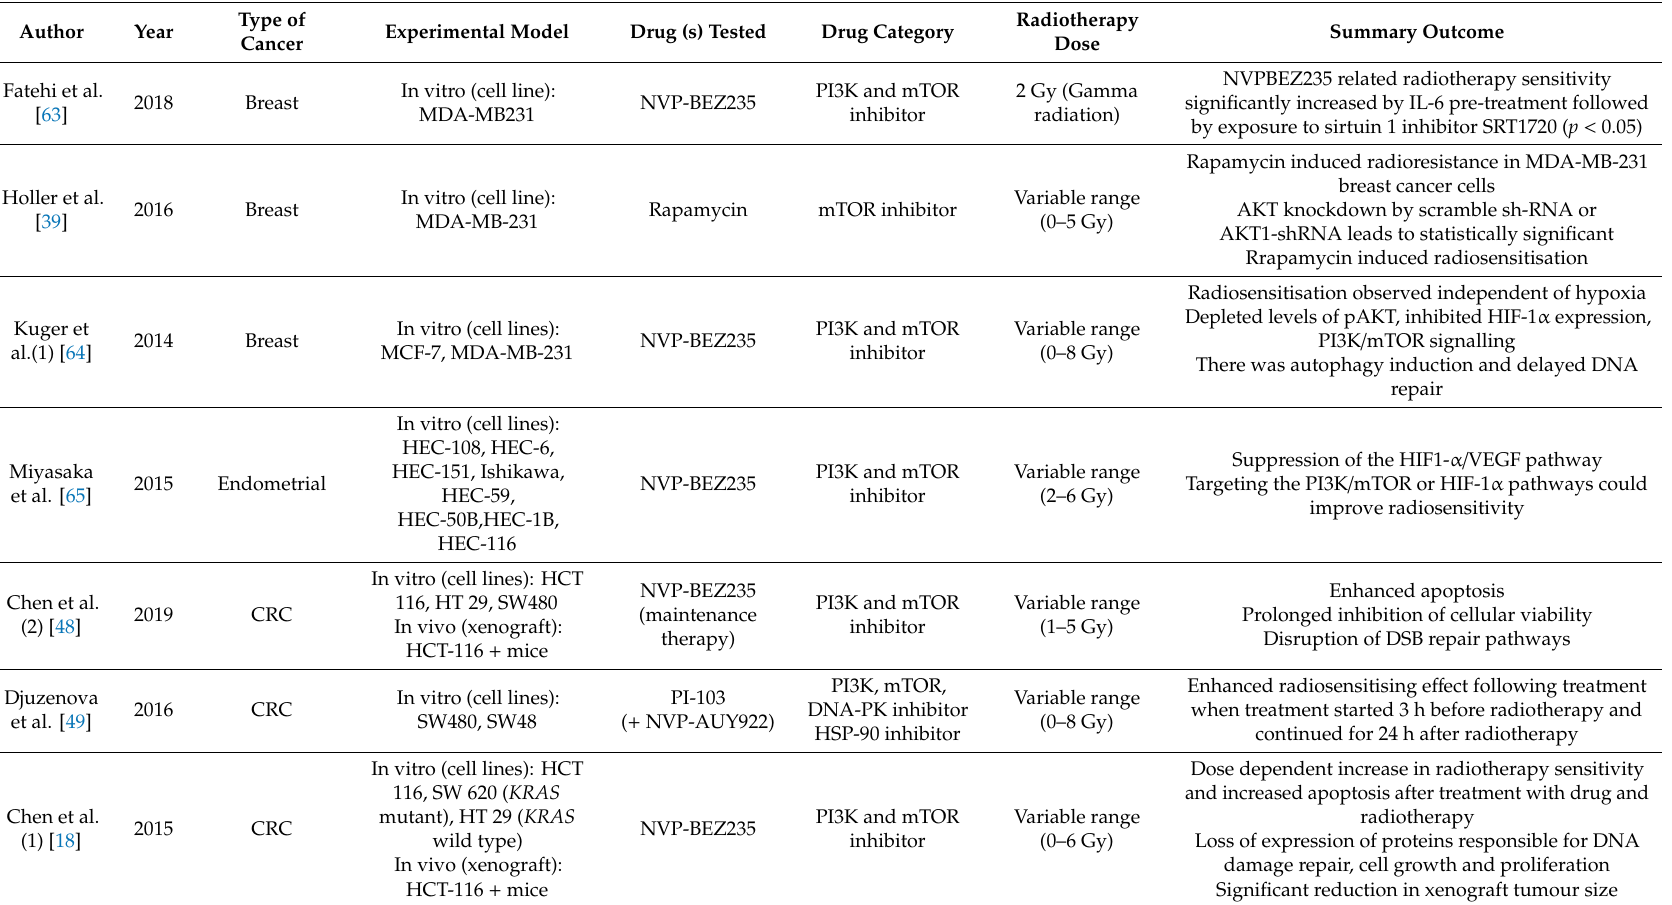
Table 1. Preclinical studies exploring the role of PI3K, AKT and / or mTOR inhibitors radiosensitising